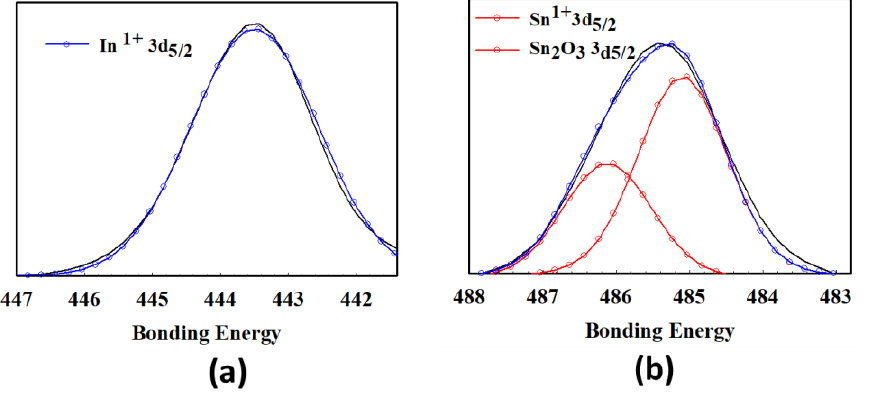
Figure 3. The XPS results of the ITO X thin films for ( a ) In 1+ 3d 5/2 , and ( b ) Sn 1+ 3d 5/2 , Sn 2 O 3 3d 5/2 peaks. Figure 3 presented the XPS measurement of the transparent ITO X thin films for (a) In 1+ 3d 5/2 , and (b) Sn 1+ 3d 5/2 , Sn 2 O 3 3d 5/2 peaks. In Figure 3, the In 1+ 3d 5/2 and Sn 1+ 3d 5/2 bonding energy of the trans-